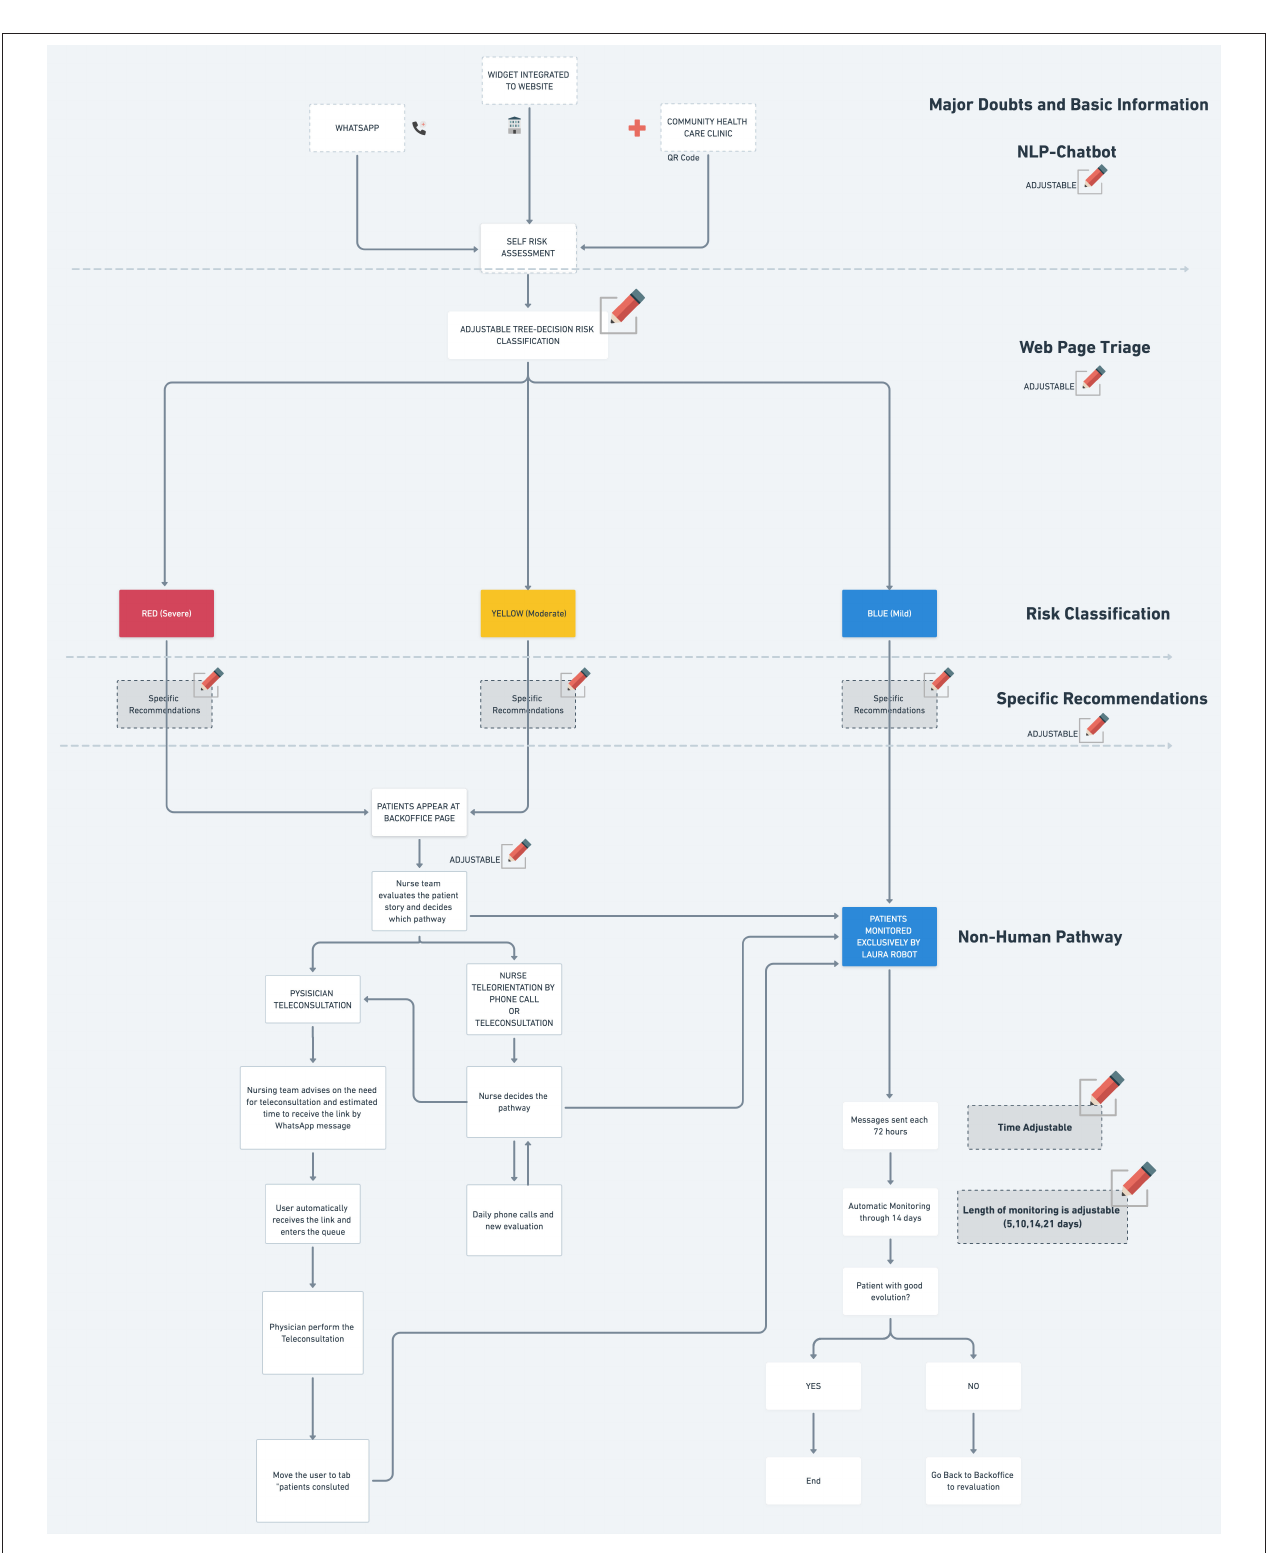
FIGURE 1 | AI-chatbot for risk COVID-19 severity risk assessment. The flow-chart describes all steps in the interaction between patients and the algorithm, as well as the indicated interventions according to the COVID-19 severity based on symptoms assessment evaluation by the technology.